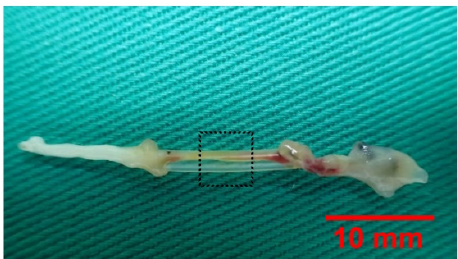
Figure 2. The nerve cable in the silicone rubber conduit after removal from the rat. The boxed area is where the specimens were taken for histological analysis. Scale bar = 10 mm.